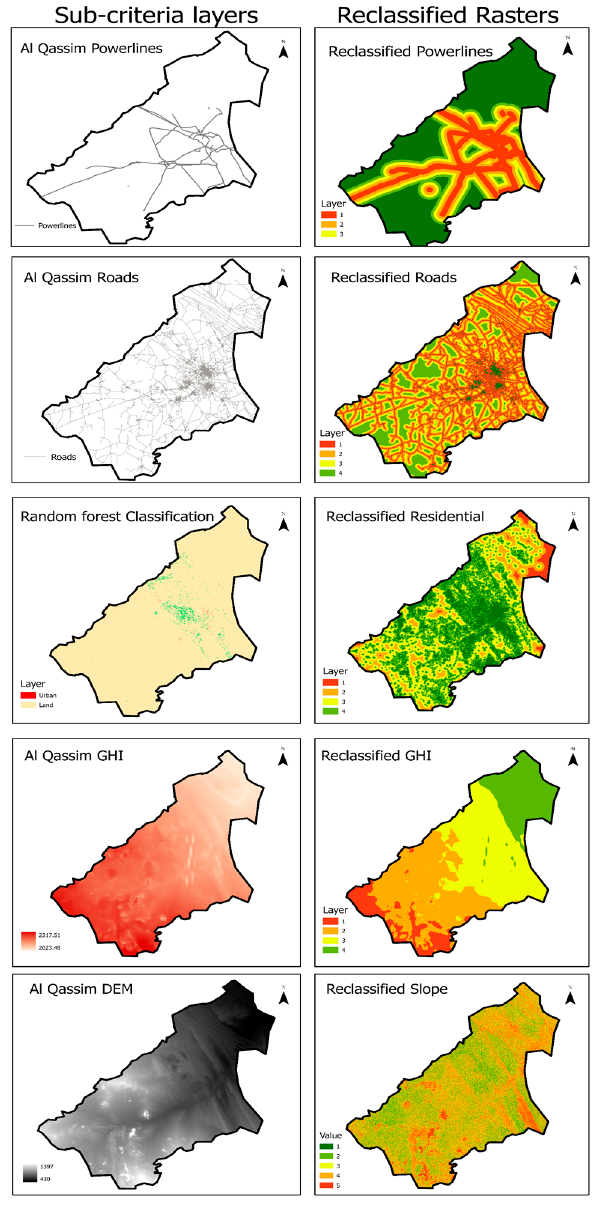
Figure 6. The sub-criteria layers and the reclassified raster of each layer.